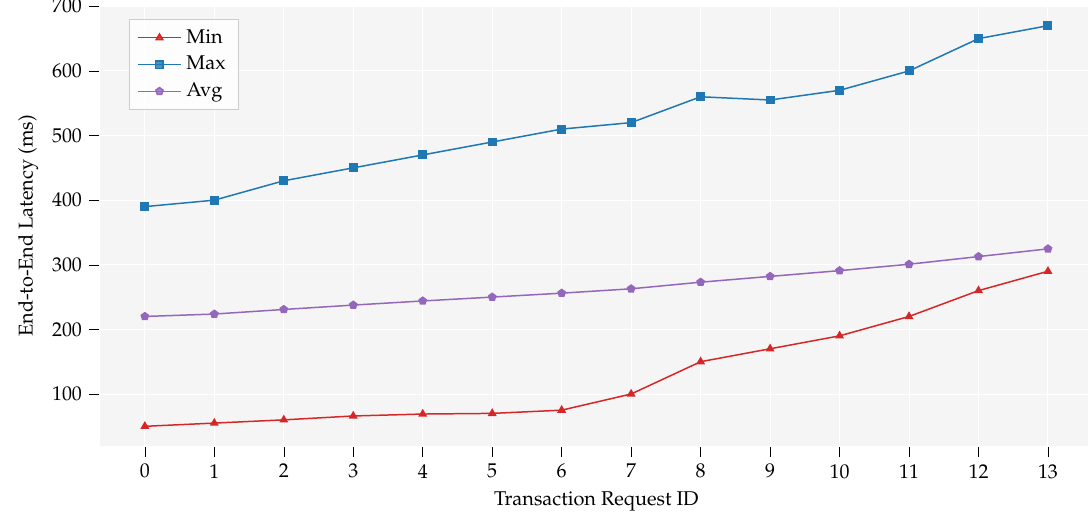
Figure 6. Impact of concurrent transactions on end-to-end transaction